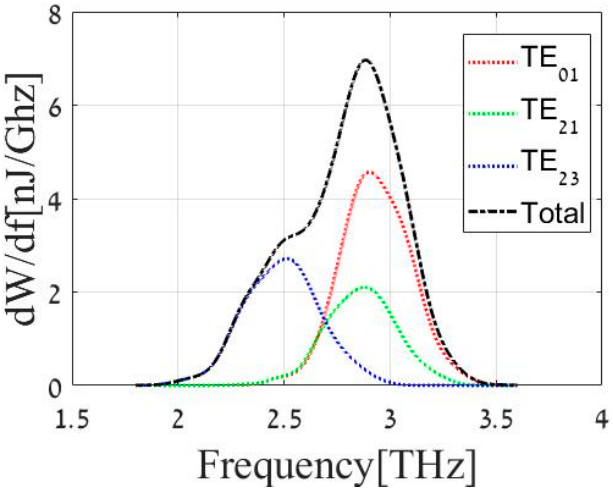
Figure 3. Output amplitude radiation spectrum of Israeli free-electron THz source.